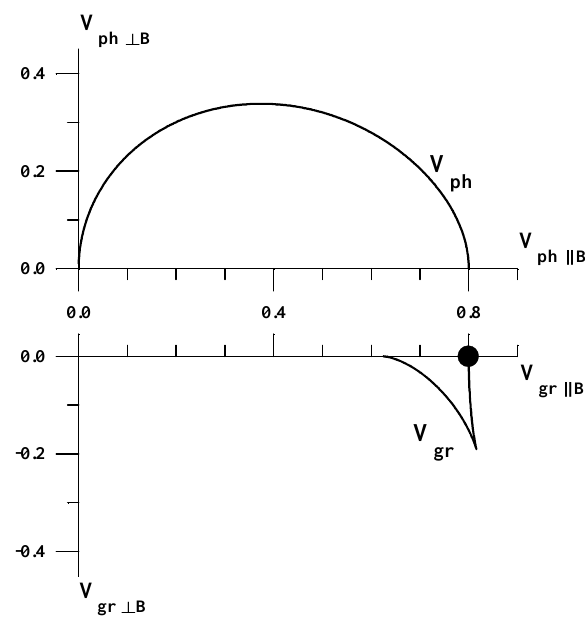
Fig. 3. Phase polar diagram for slow magnetoacoustic wave (upper plot) and the group polar diagram for a slow magnetoacoustic wave and an Alfv´en wave (lower plot). The group velocity of the Alfv´en wave is denoted by the symbol “ • ”. It is assumed that V A = 0 . 8 · c s . In the plots all velocities are normalised by the sound